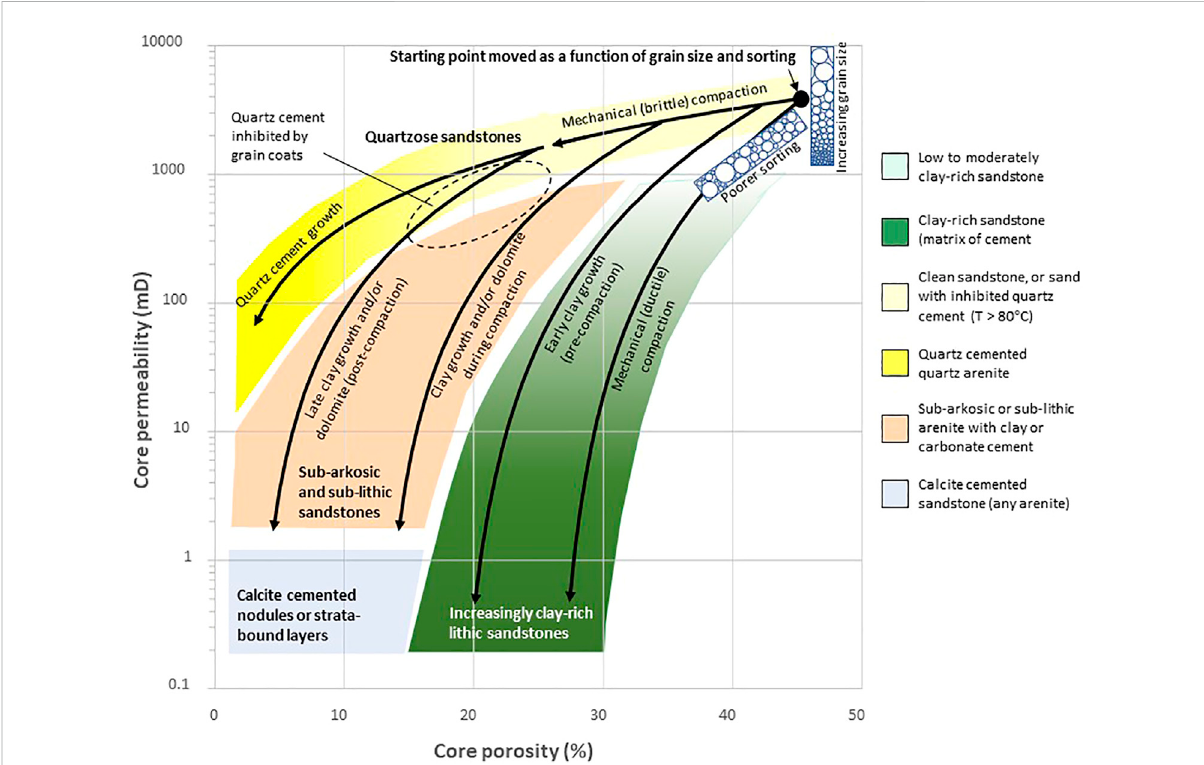
FIGURE 2 Core porosity versus core permeability for sandstones. Porosity and permeability at the time of deposition (large black dot) is a function of sorting(shownbycartoon).Permeabilityofsandandsandstoneisalsoafunctionofgrainsize(alsoshownbycartoon),withcoarsersandstonehaving higherpermeabilitythan fi nesandstone.Burialofcleansandstoneswithfewductilegrainsormatrix(paleyellowarea)reducesporositytoabout26% due to grain rearrangement and the adoption of a rhombohedrally close-packed fabric; permeability also decreases – in this diagram modelled using a Kozeny-Carman equation modi fi ed for tortuosity (Tiab and Donaldson, 2015). Sands rich in weak, ductile grains or matrix (green area) and sands with early clay cement lose porosity more quicklywith increasing depth than sandscomposedsolely ofstrong grains and the presence of clay in pore throats leads to very low permeability values even when the porosity is ~20%. Sands with calcite cement tend to acquire the cement soon after deposition and have very low porosity and permeability (blue area). Clean sands undergo chemical compaction and quartz cementation once thetemperatureexceedsabout80 ° C(brightyellowarea)withamutedlossofporosityandpermeability(BourbieandZinszner,1985).Quartzcement growth can be inhibited by chlorite-, microquartz- and siderite-grain coats (black dashed oval) leading to porosity close to the minimum caused by mechanical compaction and commensurately high permeability deep in sedimentary basins. Intermediate and late clay and carbonate cement growth (pale brown area), during or following mechanical compaction and typical of sub-arkosic and sub-lithic sandstones (Primmer et al., 1997), lead to porosity reduced below 26% and much-reduced